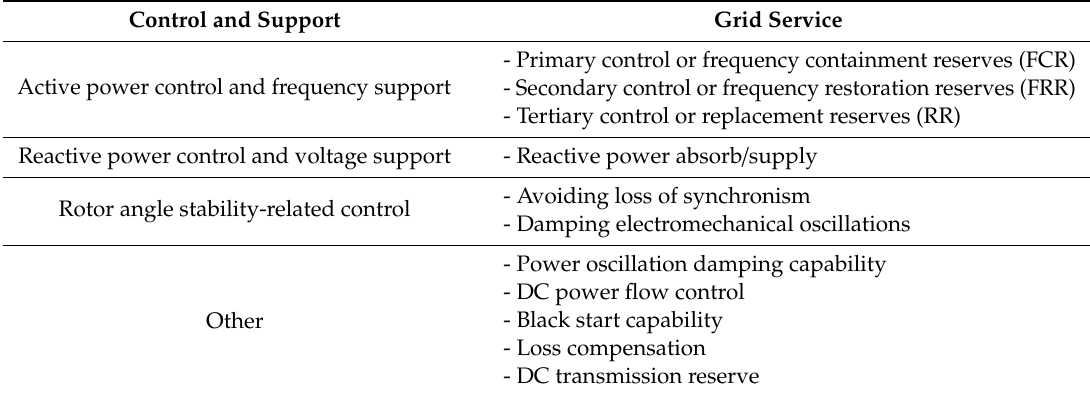
Table 1. Grid services of voltage-sourced converter (VSC) high voltage direct current (HVDC) for alternating current (AC)